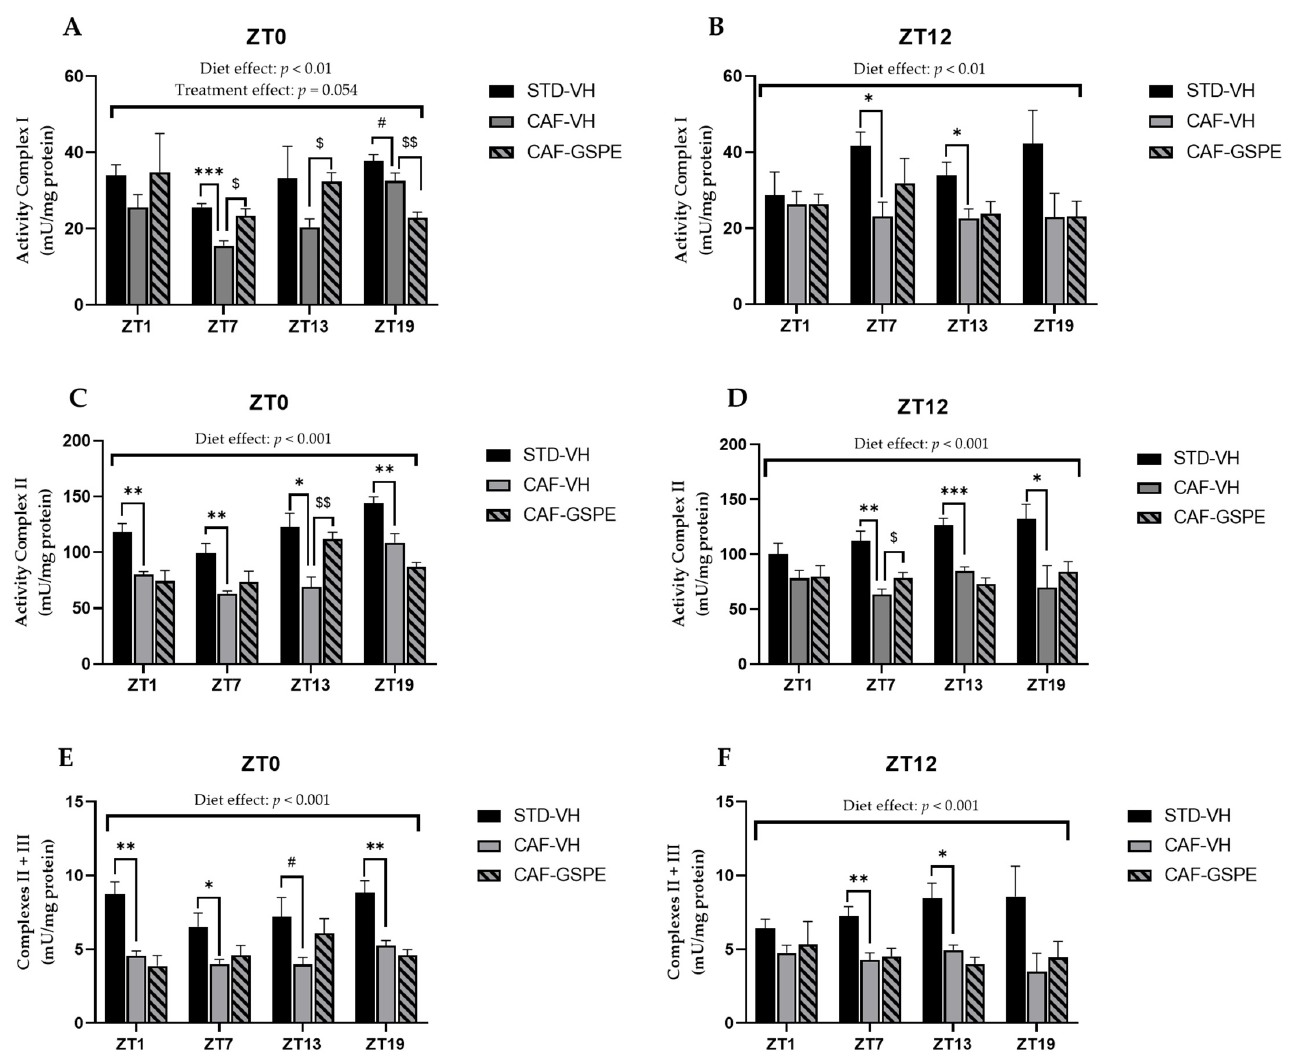
Figure 7. Mitochondrial respiratory activity in the liver. Rats were fed an STD or CAF diet and received a daily dosage of vehicle or GSPE in the morning (ZT0) ( A , C , E ) or at night (ZT12) ( B , D , F ). After 9 weeks, the rats were sacrificed at 9 a.m. (ZT1), 3 p.m. (ZT7), 9 p.m. (ZT13) or 3 a.m. (ZT19), and the activity of mitochondrial complexes I, II and III was determined. The values are the mean ± SEM ( n = 4). * The effect of diet within vehicle groups (Student’s t test or DMS post hoc test, * p ≤ 0.05, ** p ≤ 0.01, *** p ≤ 0.001); $ the effect of GSPE consumption within CAF groups (Student’s t test or DMS post hoc test, $ p ≤ 0.05, $$ p ≤ 0.01); # indicates tendency between STD-VH and CAF-VH using Student’s t test ( p = 0.1–0.051).